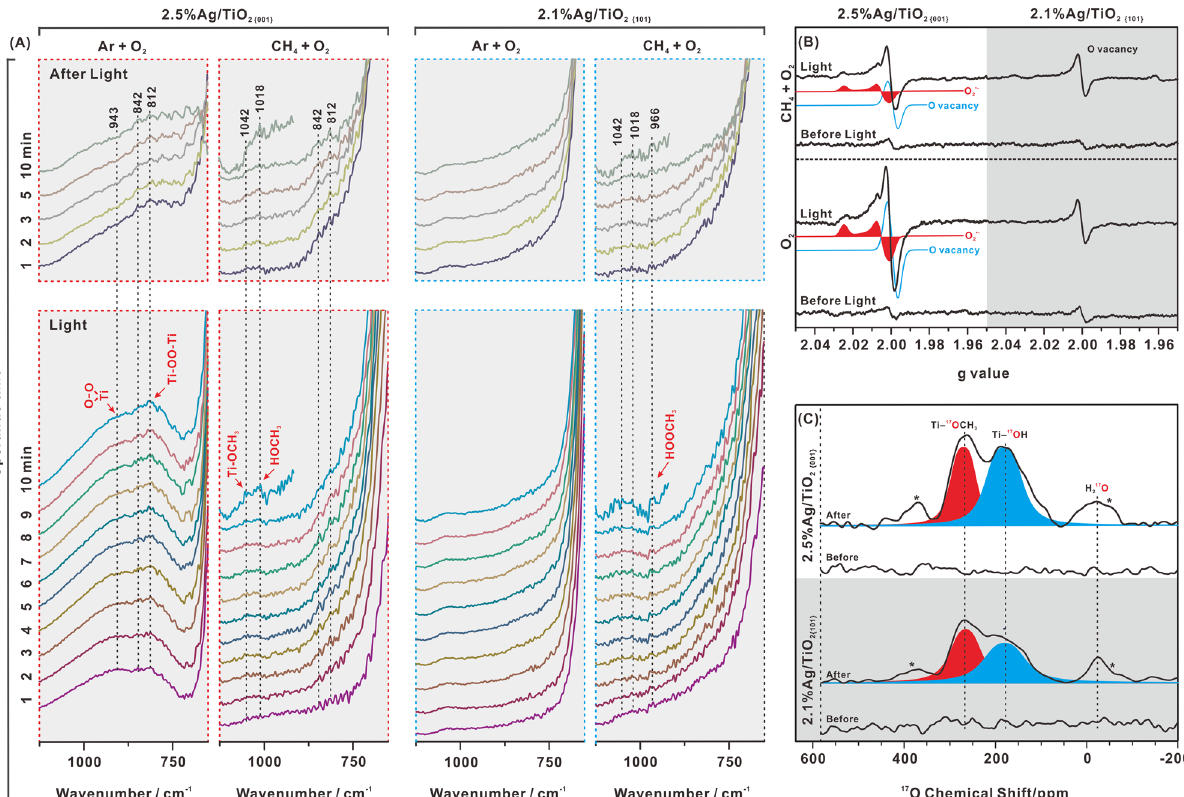
Fig. 3 Reactive intermediates on the {001} and {101} facets. A Operando ATR-FTIR matrix for 2.5%Ag/TiO 2 {001} and 2.1% Ag/TiO 2 {101} with a 4 mL aqueous phase in a (Ar + O 2 ) and (CH 4 + O 2 ) atmospheres before, during, and after light irradiation. B In situ ESR spectra for 2.5%Ag/TiO 2 {001} (left) and 2.1% Ag/TiO 2 {101} (right) with 300 µ mol H 2 O loading in O 2 (bottom) and (CH 4 + O 2 ) (upper) atmospheres before and during light irradiation. We fi t the ESR data with the easyspin programs. C Ex situ 17 O NMR spectra for 2.5%Ag/TiO 2 {001} (upper) and 2.1% Ag/TiO 2 {101} (lower) in a (CH 4 + 17 O 2 ) atmosphere before and after light irradiation. The signals marked by asterisks are spinning sidebands. We fi t the 17 O NMR data with the Dim fi t